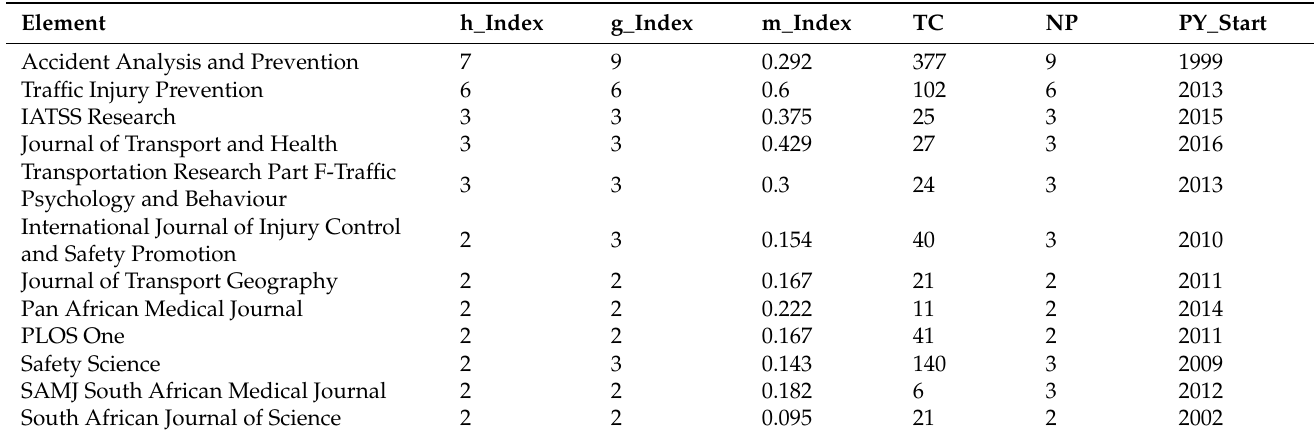
Table 2. Citations and publications per